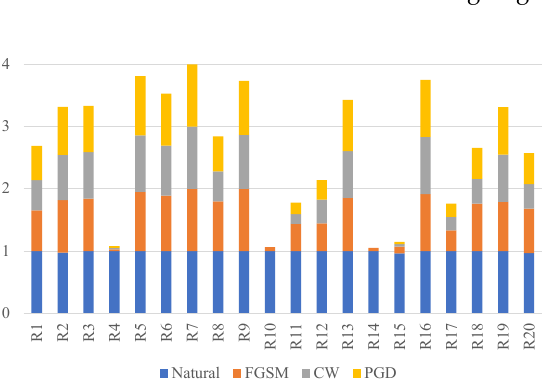
Figure 12. Recognition results of each emitter under different types of attacks at a strength of − 32 dB for Dataset 1. The horizontal axis indicates different emitters, and the vertical axis indicates the corresponding recognition rate values. Different color blocks indicate the recognition effect of different cases, the length of the blocks is proportional to the size of the correct recognition rate. The longer the length, the higher the recognition rate. The values range from 0–1 (100%). The total range is 0–4 for all four cases.